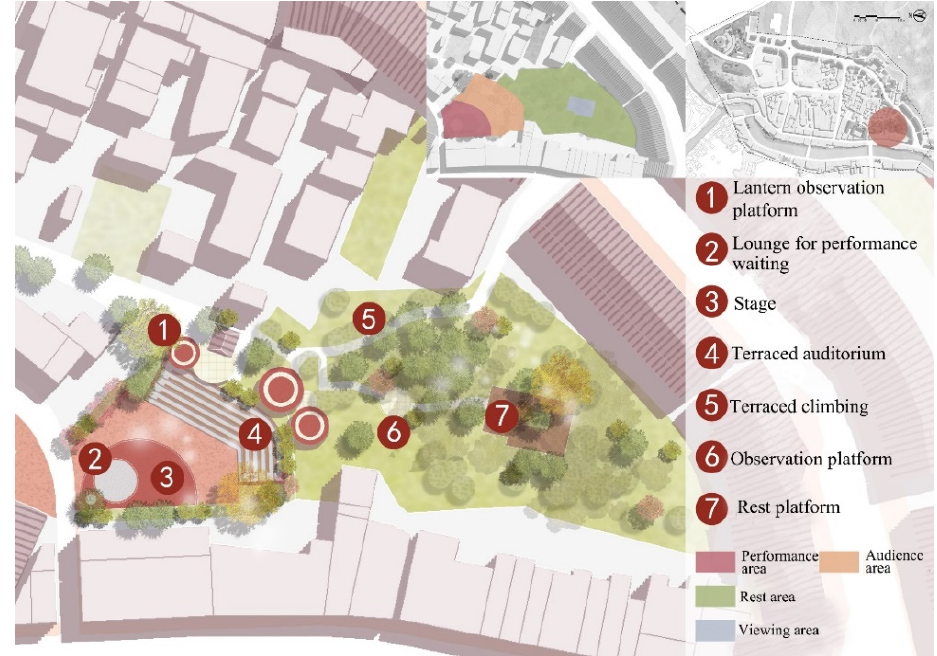
Figure 15. Plan of Activity performance experience zone landscape. The lantern viewing platform uses the red lantern, the most representative of Taishun’s Hundred-family Feast culture, as a landscape element. The skeleton form in the lantern is used as the supporting structure and railing of the viewing platform, the red body of the lantern is used as the top of the landscape platform to shelter from the rain, and the lantern’s lamp holder is decorated on the top of the landscape platform. The whole form is combined similar to a red lantern hanging in a high place, full of good symbolic meaning (as illustrated in Figure 16).